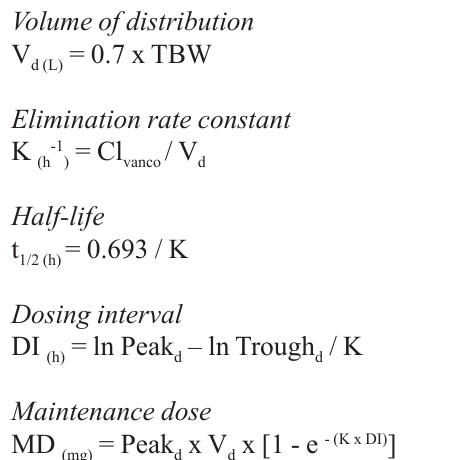
TABLE I - Vancomycin dosing nomogram for adults according to total body weight and renal function